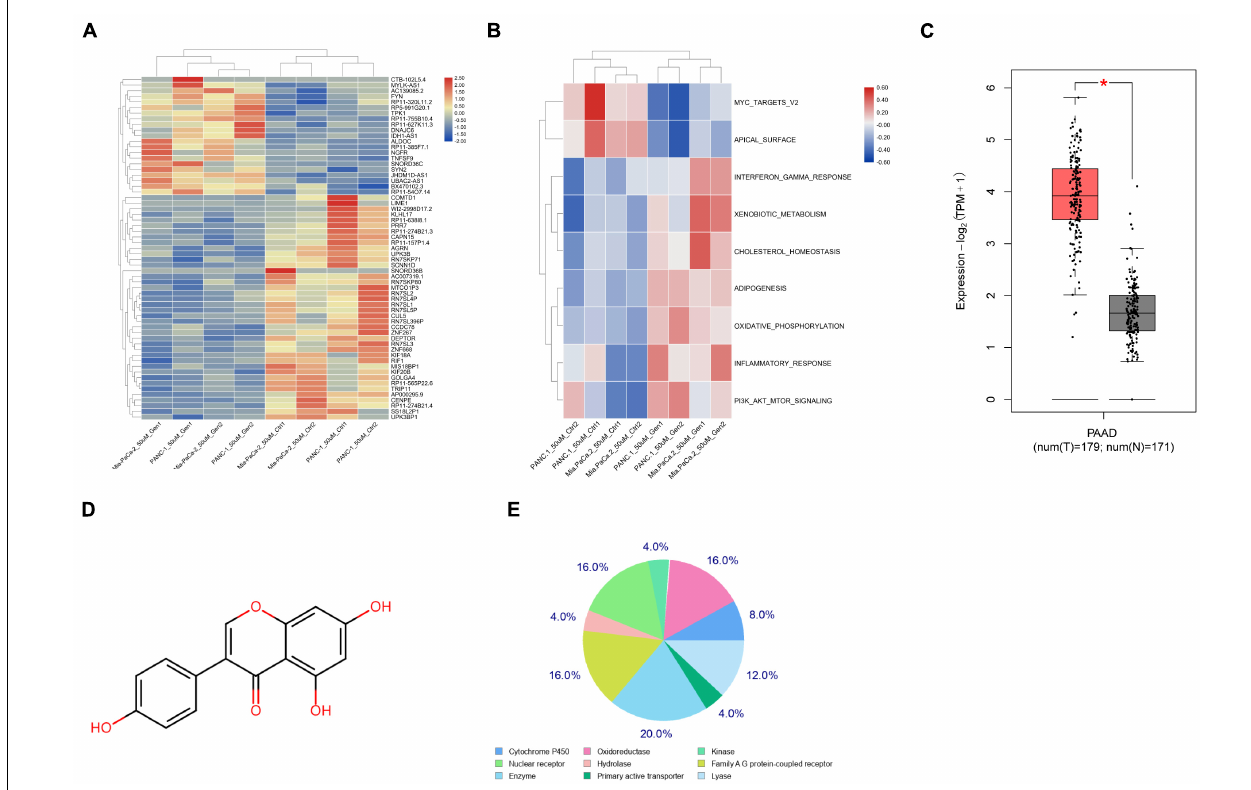
FIGURE 1 | DEPTOR expression is notably decreased in the genistein-resistant cells. (A) A heatmap for differentially expressed mRNAs between drug-resistant and drug-sensitive cells according to a GEO GSE97766 dataset. (B) Aberrantly activated signaling pathway according to the differentially expressed mRNAs analyzed through GSVA. (C) DEPTOR expression predicted on the TCGA-GTEx Database; (D) the chemical structure of genistein. (E) Candidate target genes of genistein predicted using the Swiss Target Prediction system. Data were collected from three independent experiments and presented as mean ± SD. * p <